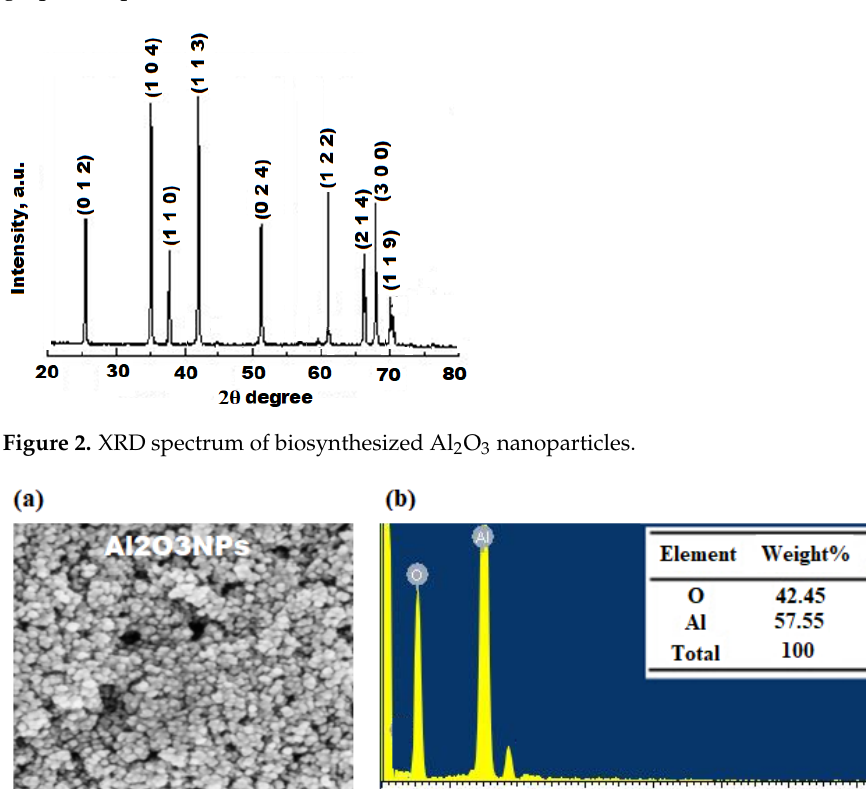
Figure 1. ( a ) UV–vis and ( b ) FTIR spectra of biosynthesized Al 2 O 3 nanoparticles at 278 nm and 4000–500 cm ‒ 1 .